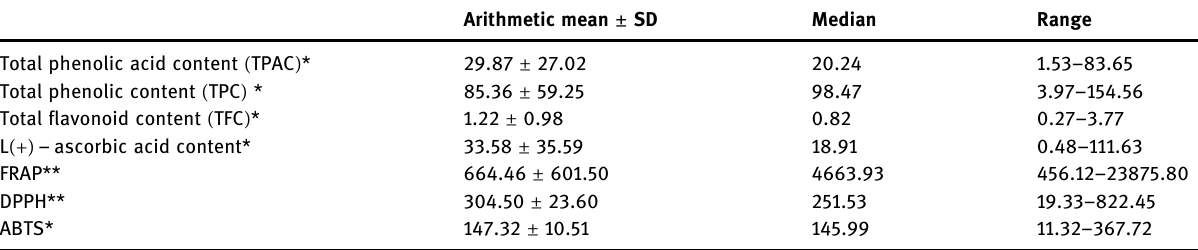
Table 4: Results of phenolic compounds content and antioxidant activity determination in 10 medicinal plants from